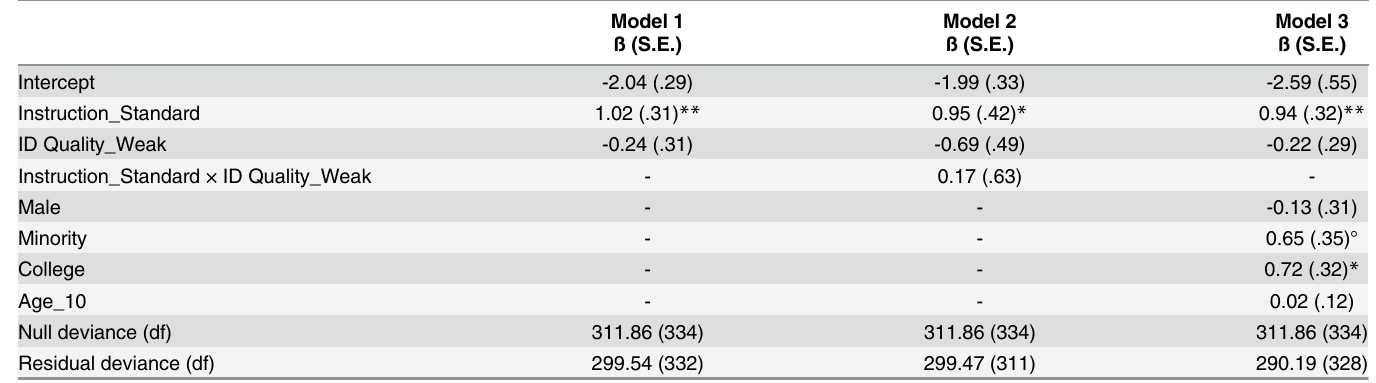
Table 2. Logistic regressions predicting a verdict of guilt.